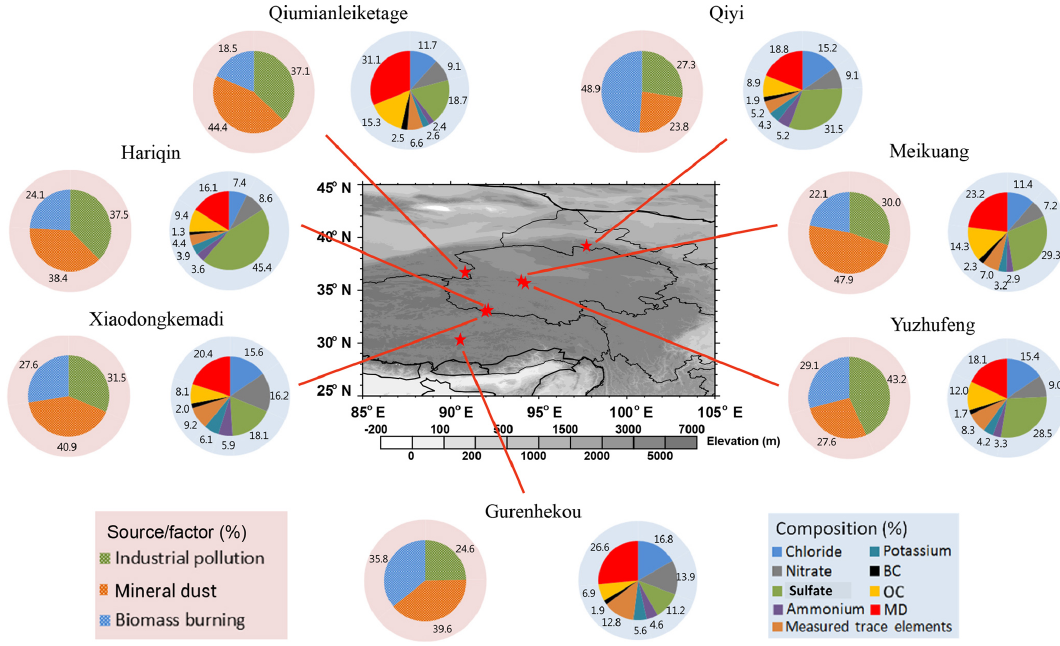
Figure 10. Chemical composition and source apportionment for the seven TP glaciers. Note that the apportionment applies to the light absorbed by insoluble particles on the glacier